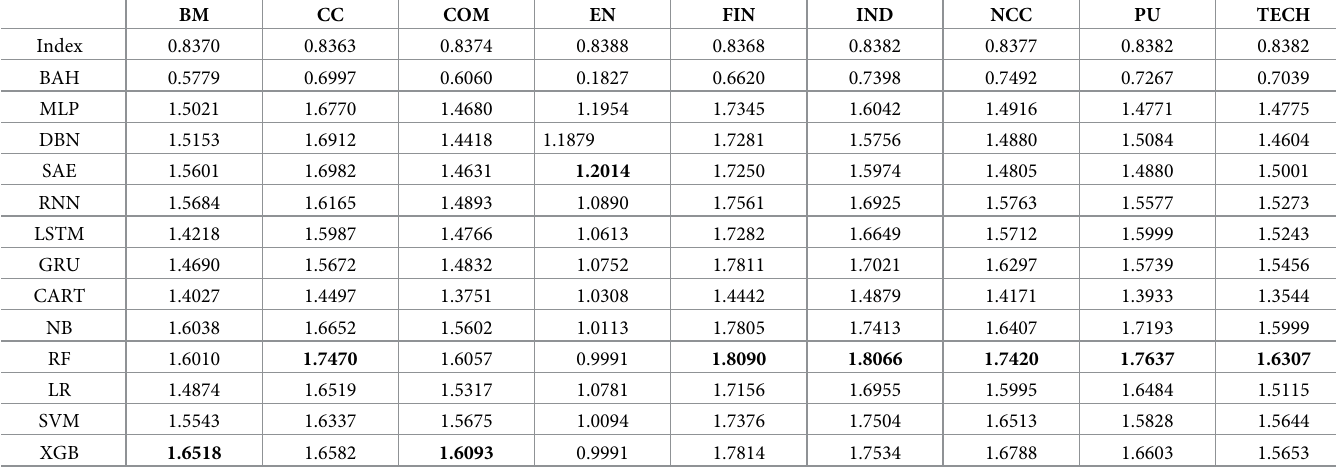
Table 6. Comparison of the ASR of various trading strategies in the different industries of SPICS. Best performance is in boldface.